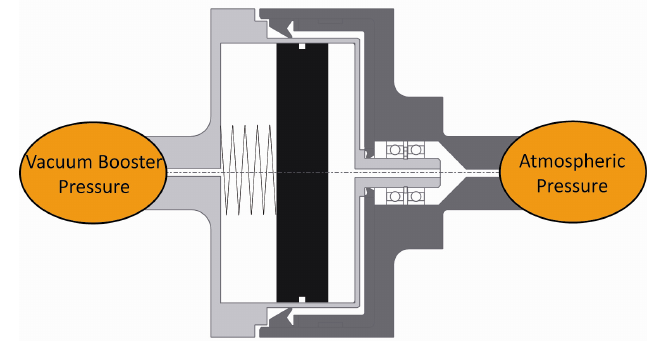
Figure 7: Clutch actuation principle.